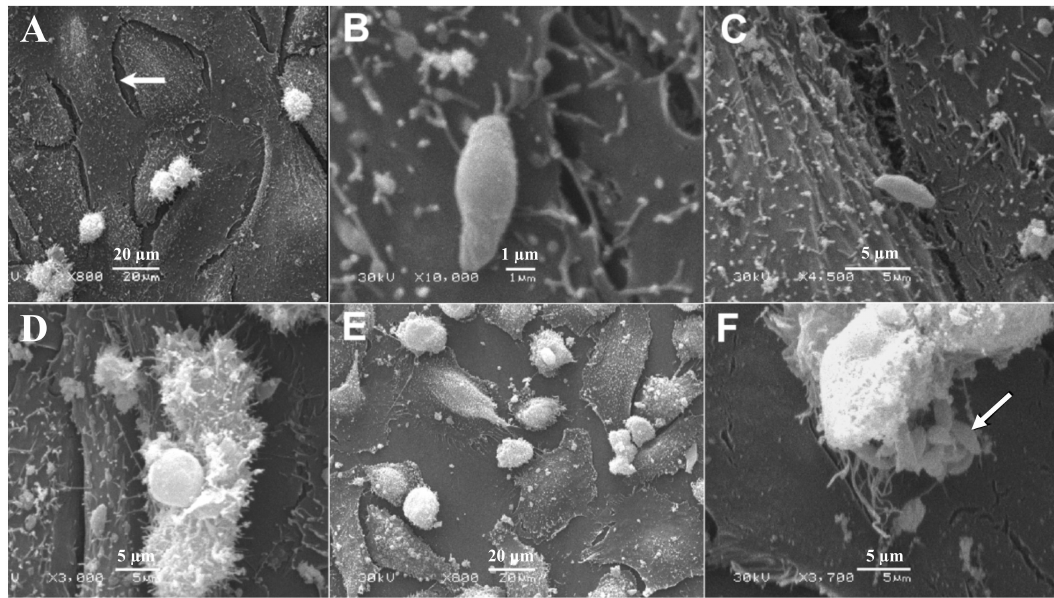
Figure 3. Scanning electron micrographs of BMECs infected by T. gondii tachyzoites. ( A ) A confluent monolayer of uninfected control BMECs showing normal intercellular space (arrow). ( B ) At 6 hpi tachyzoites came in close contact with cells, with the anterior ends of the tachyzoites embedded in the intercellular space ( C ). A large gap is evident between infected cells at 24 and 48 hpi ( D , E ), compared to 6 hpi ( B , C ) and to uninfected control cells ( A ). By 48 hpi tachyzoites were observed exiting from the host cell ( F ) and a number of newly generated tachyzoites were visible